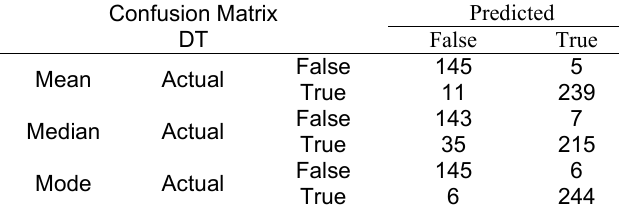
Table 4. Confusion Matrix for Decision